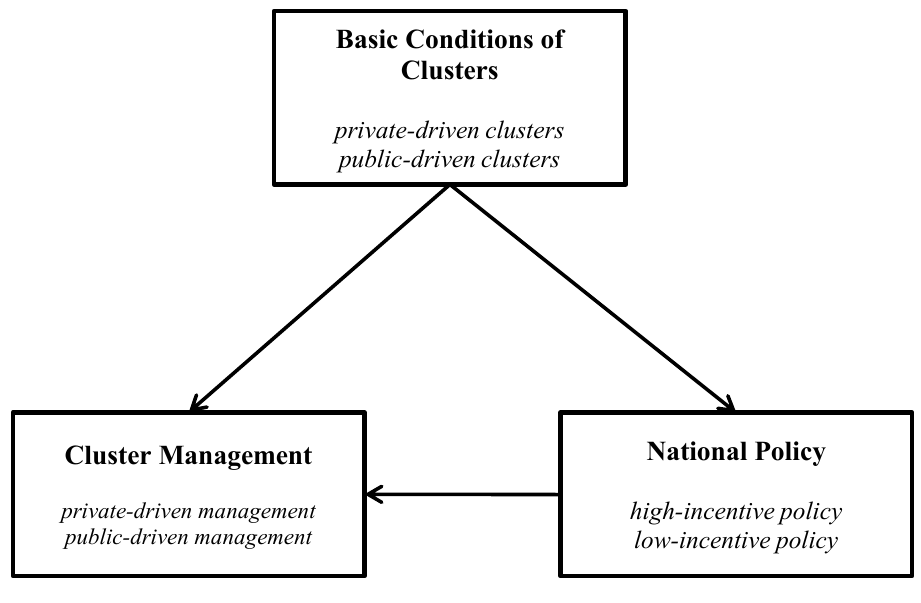
Figure 1. Conceptual